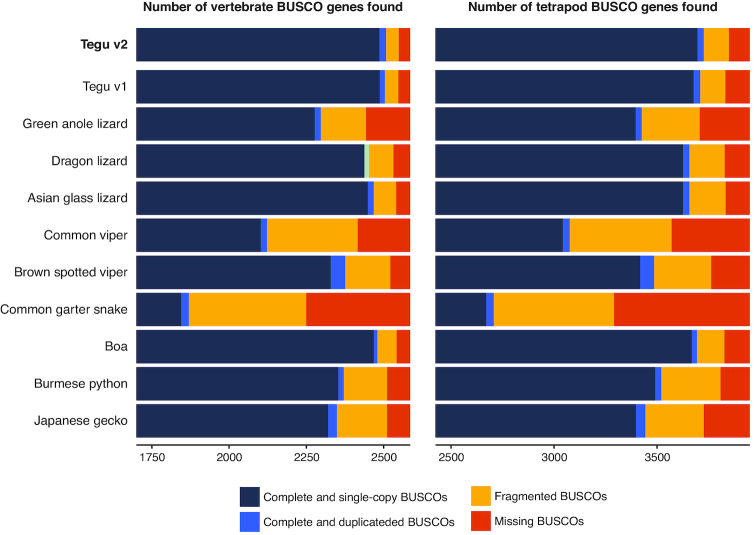
Comparison of genome completeness for coding genes. The bar charts show the number of complete, fragmented, and missing genes using two BUSCO datasets for vertebrate-conserved (left) and tetrapod-conserved (right) genes.